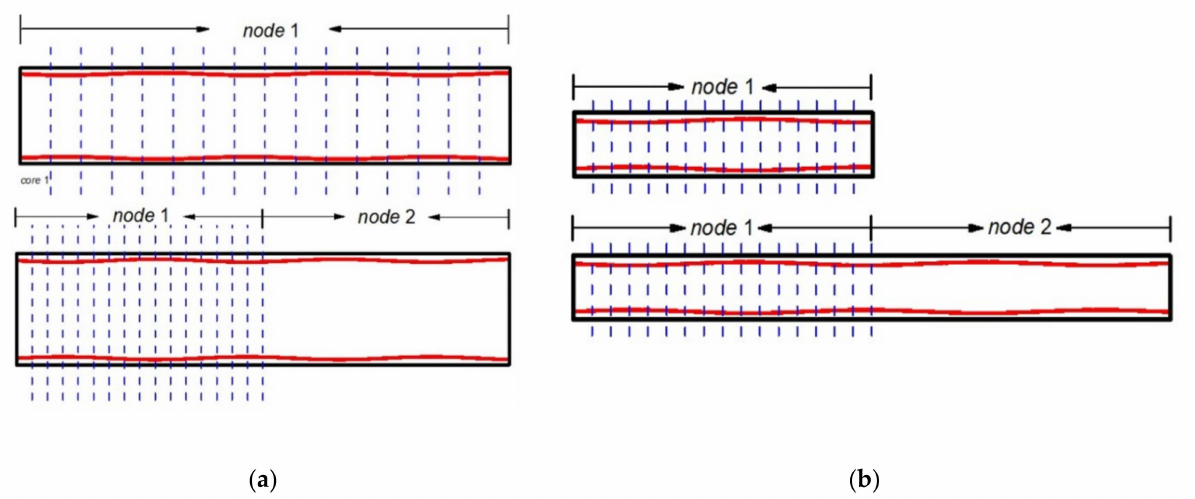
Figure 9. Schematic diagram of two parallel performances: ( a ) The first type; ( b ) The second type.